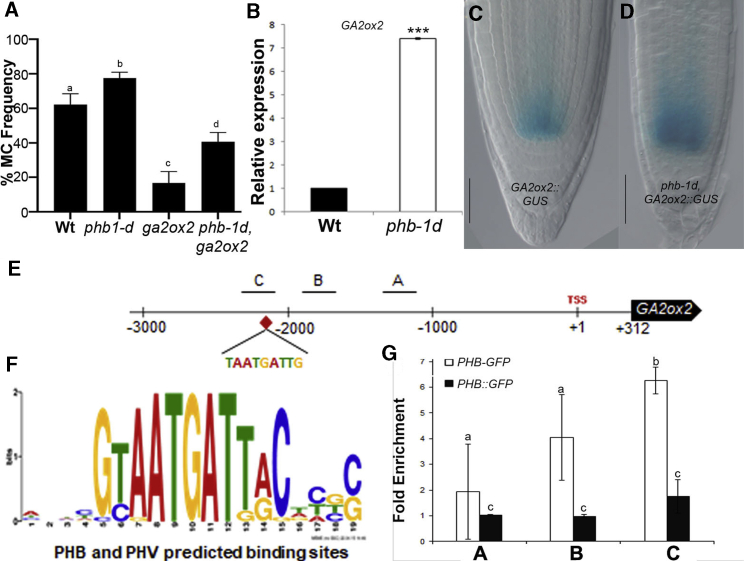
PHB Directly Regulates GA2ox2 Expression(A) Histogram depicting the percentage of MC formation in WT; phb-1d, ga2ox2-1; and phb-1d, ga2ox2-1 plants at 8 dpg. p < 0.005; ANOVA. Different letters show statistical significance.(B) GA2ox2 relative expression in WT and phb-1d plants.(C and D) Root meristems of GA2ox2::GUS (C) and phb-1d, GA2ox2::GUS (D) plants at 5 dpg. Scale bars, 50 μm.(E and F) GA2ox2 promoter illustration. TSS indicates the transcriptional start site (+1) and the fragments used as probes for the ChIP experiment are marked with A (−1,186/−1,214 bp), B (−1,755/−1,909 bp), and C (−2,123/−2,271 bp). The red rhombus indicates the putative binding site of PHB and PHV, TAATGATTG (PlantPAN2.0) illustrated in (F).(G) ChIP experiment using root meristems of PHB-GFP at 8 dpg. Fold enrichment of PHB-GFP on the indicated fragments A, B, and C was determined by qRT-PCR and calculated as ratio of anti-GFP IP to control beads immunoprecipitation (IP) of each independent replicate. UBQ10 was used for normalization.(A and B) n = 20, N = 3; Student’s t test (∗p < 0.05; ∗∗p < 0.01; ∗∗∗p < 0.005). Error bars: SD. See also Figure S3.